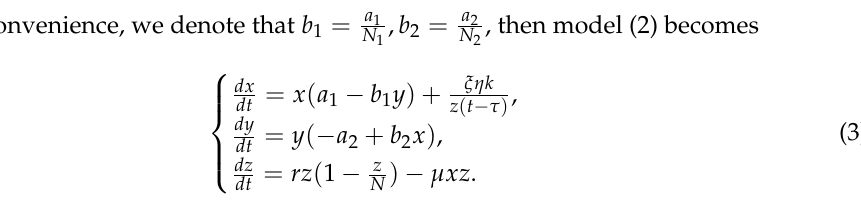
Table 1. Descriptions of variables and parameters in the model